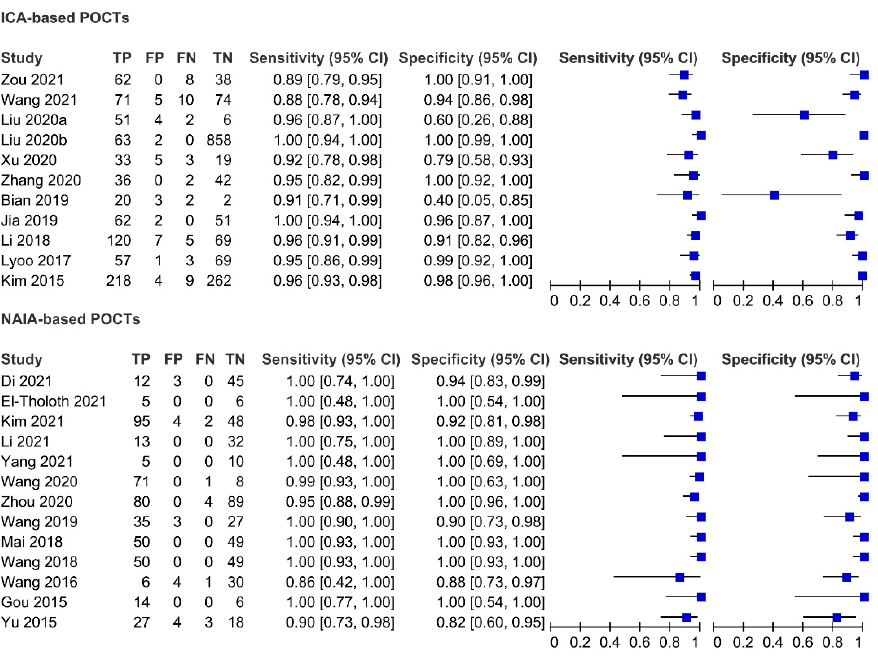
Table 2. Summary estimates of the diagnostic accuracy of ICA- and NAIA-based POCTs used to detect PEDV.